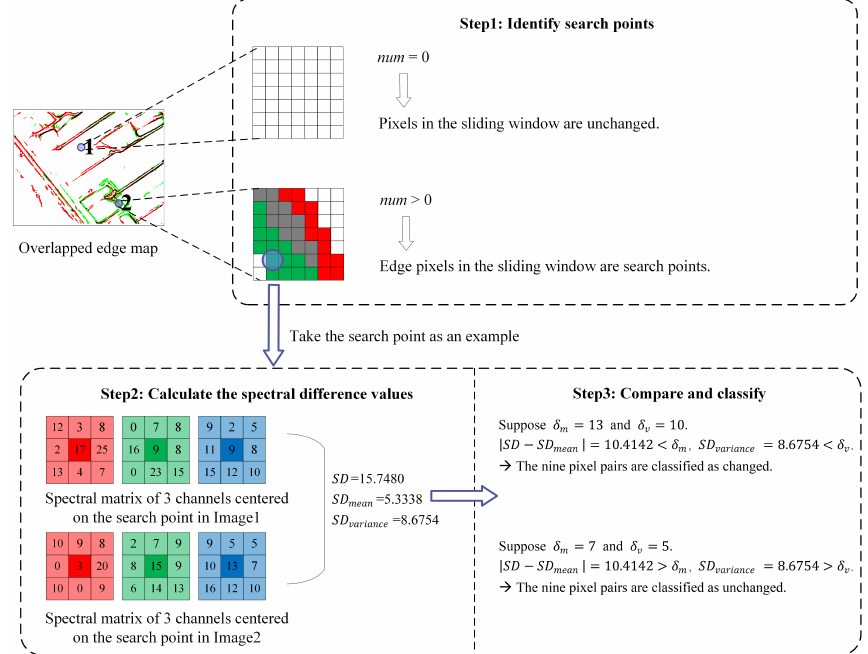
Figure 2. An example for pre-classification. (1) count the number of edge pixels in the sliding window to identify search points; (2) calculate the spectral difference values of the search point and the neighbor pixels; (3) compare and classify according to δ m and δ v